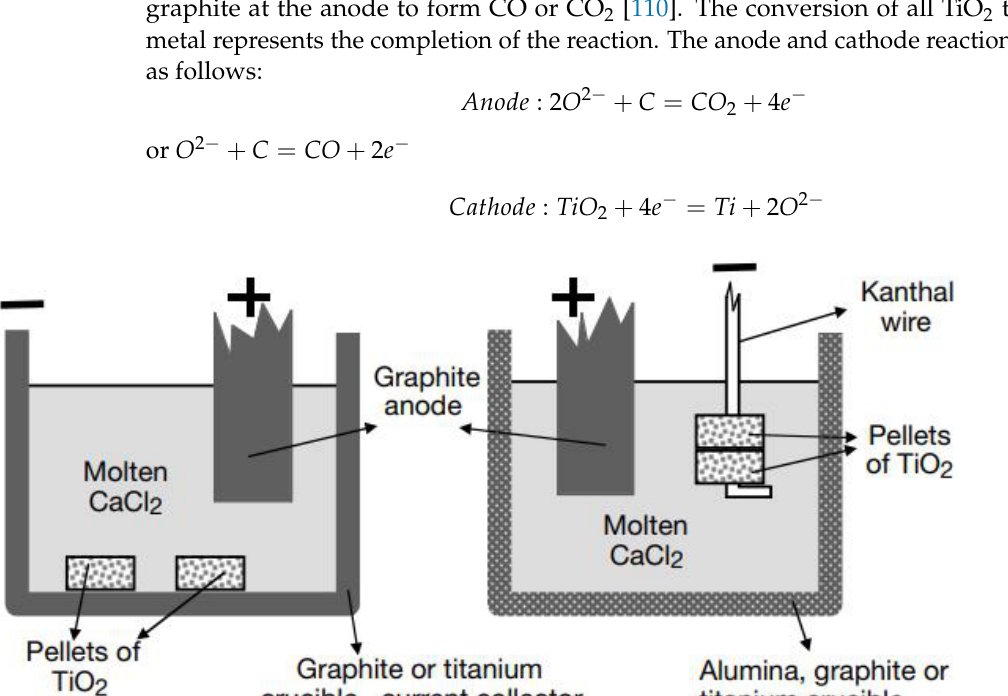
Figure 10. Schematic illustration of the FFC process [109] (Adapted from [109], with permission from Springer Nature, 2000).